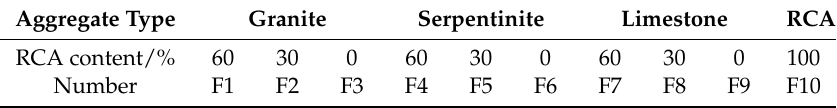
Figure 5. Standard trabecular test pieces.